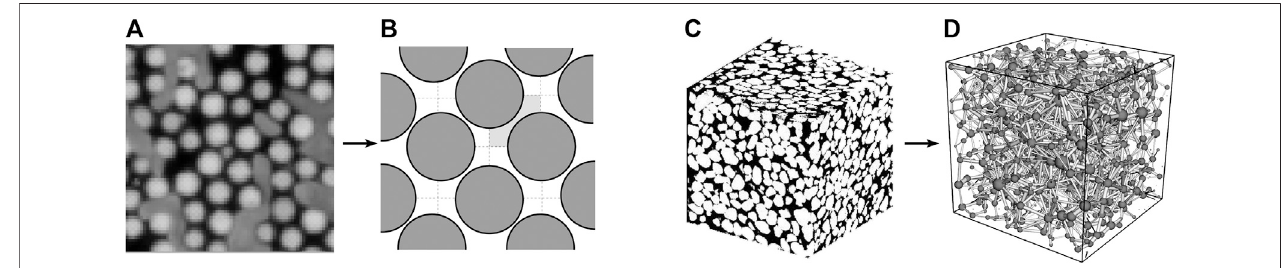
FIGURE 1 | An overview of the network representation of two and three dimensional porous media. Figure (A) shows a 10mm × 10mm crop of a 42cm × 85cm Hele-Shaw cell, fi lled randomly with a monolayer of 1mm-diameter glass beads, indicated by the white circles [50]. The black and gray colors in the image show the wetting and non-wetting fl uids. Such a system can be modeled by a two-dimensional network of hour-glass shaped links as shown in (B) , where the distribution in link radiiandnodepositionscanbetunedaccordingtothesystemproperties.In (B) ,thedarkgraycirclesrepresentthebeadsandwhiterepresentsthepores.Thelinks are separated by dotted lines and the intersection of two such lines de fi nes the position of a node. One link is colored by light gray. We like to point out that, (B) is not an exactreconstructionoftheimageshownin (A) ,ratheritisasimpli fi edillustration.In (C) ,weshowathreedimensionalMicroCTimageofsand-pack(sampleF42Ain[51]) and the corresponding reconstructed pore network is shown in (D) .